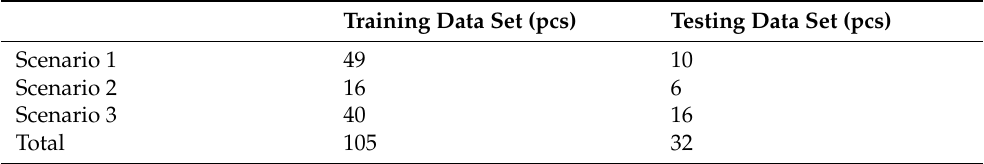
Table 2. Number of records in the data